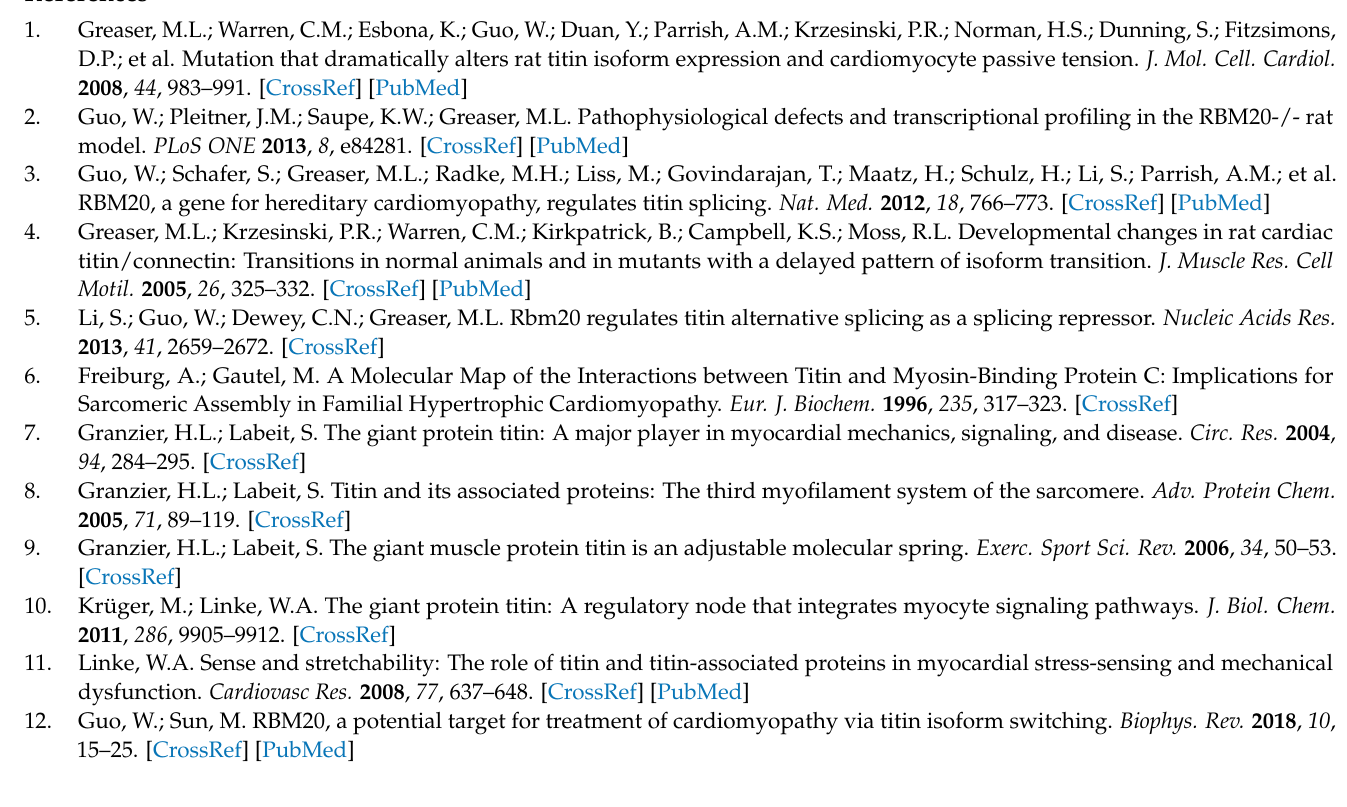
Figure S2: Coomassie staining for purified RBM20 and kinase activity assay with RBC